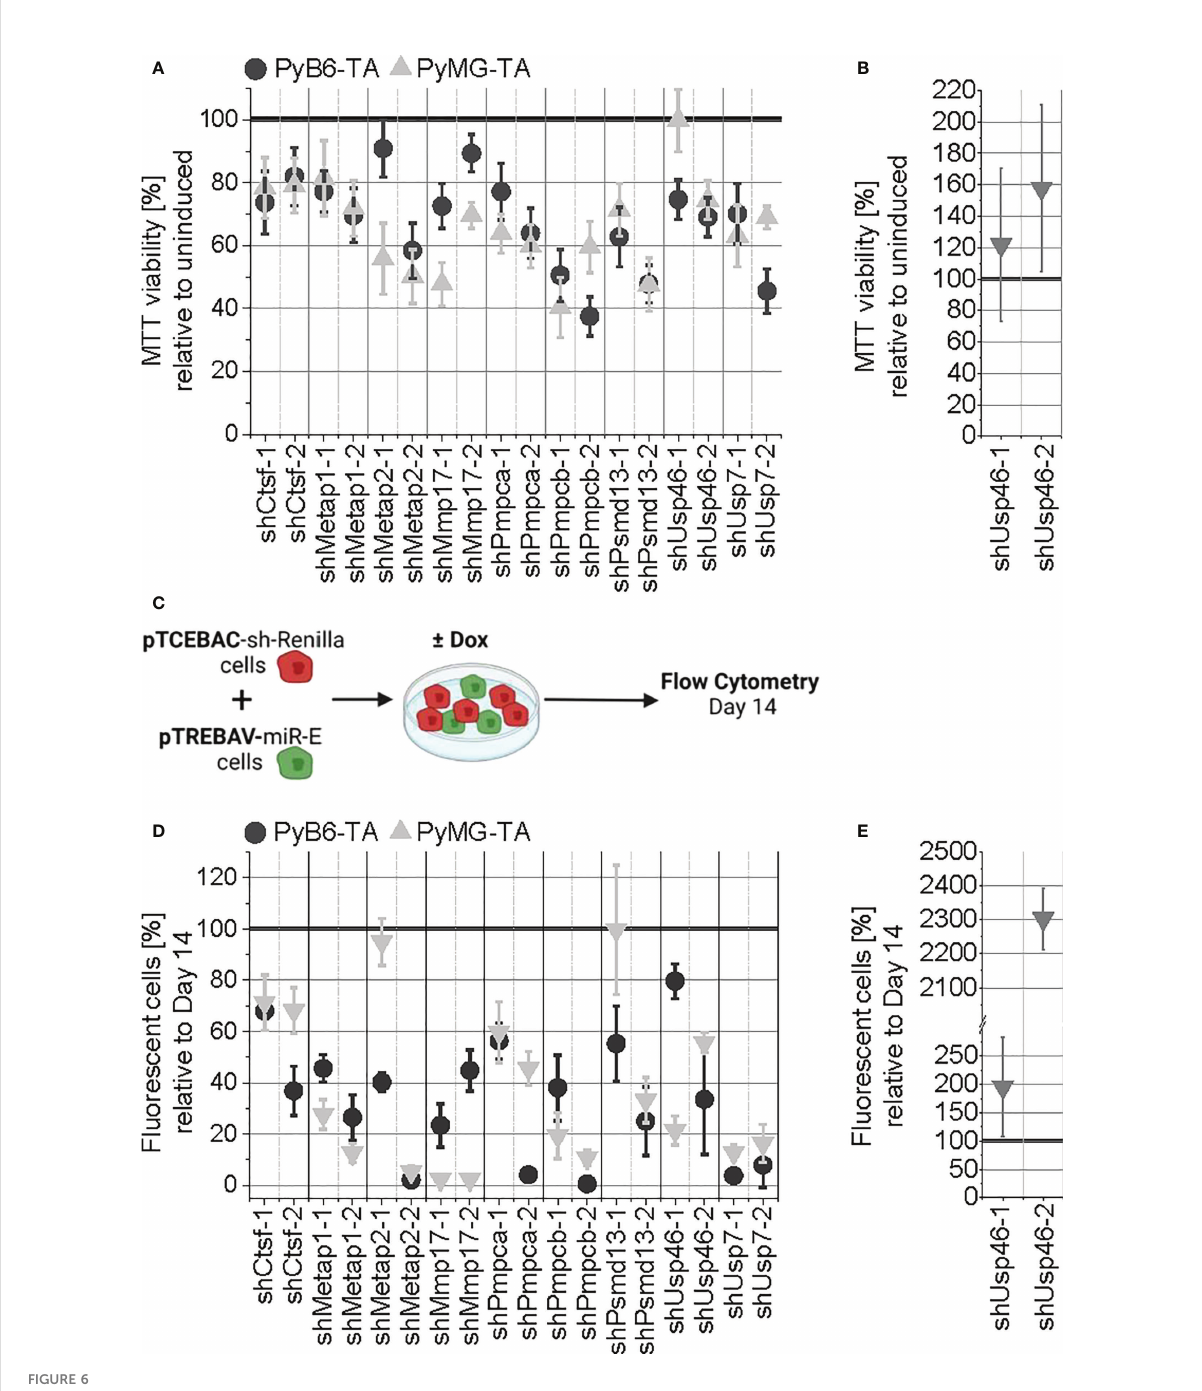
FIGURE 6 General validation of the competitive growth screen hits. (A) Short-term protease targeting in miR-E-transduced PyB6-TA and PyMG-TA cells. miR-E expression was induced for 5 days in total. Cell viability as mean ± SD (n ≥ 4) relative to untreated, uninduced cells. (B) Repetition of A performed under normoxic conditions for the mixed hit Usp46 in PyMG-TA cells (n = 5). (C – E) Long-term protease targeting in PyB6-TA and PyMG-TA cells. (C) Schematic experimental setup. (D) Flow cytometry-based percentage of Venus + dsRed + fl uorescent pTREBAV protease knockdown cells from living single cells at day 14 relative to unindicted Venus + cells as average ± SD (n ≥ 3). (E) Long-term protease targeting assay performed under normoxic conditions for the mixed hit Usp46 in PyMG-TA cells (n = 5). For simpli fi cation, miR-Es are indicated by